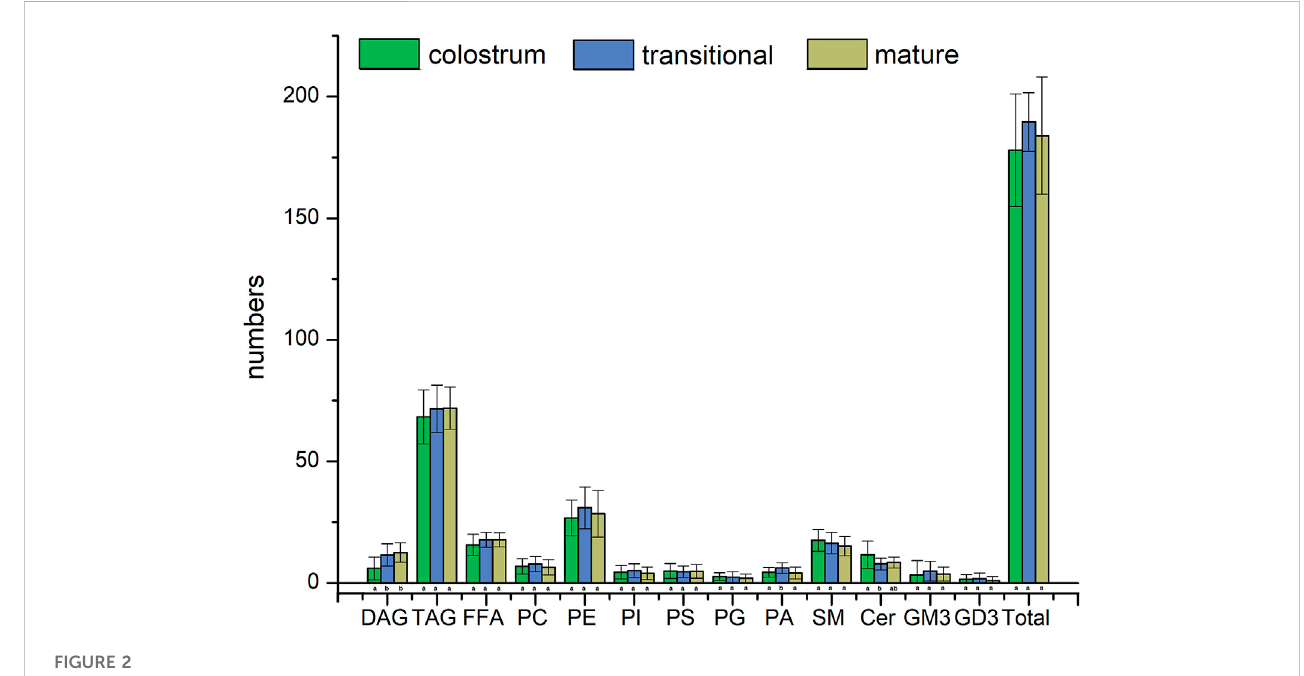
FIGURE 2 Species number of human milk lipids at different lactation stages.